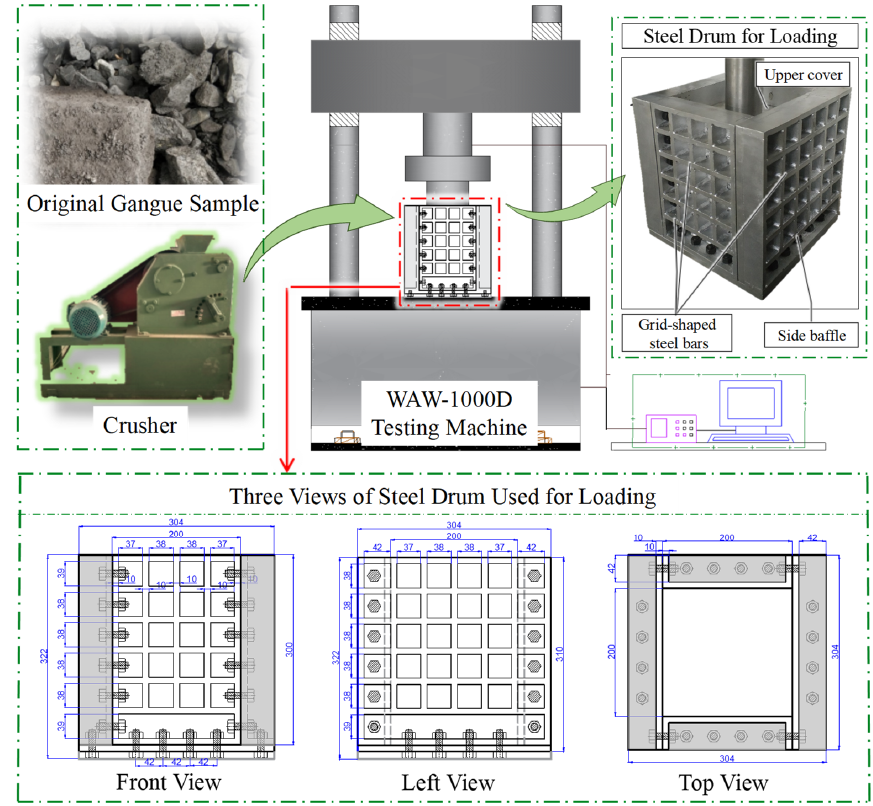
Figure 1. Compressive loading module and the test system.